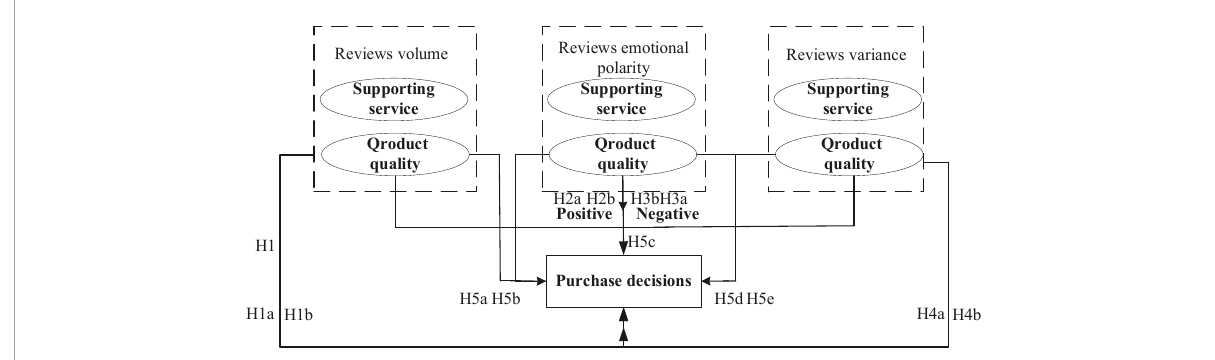
FIGURE3 A conceptual model of the influence of online reviews on consumer purchase decisions.